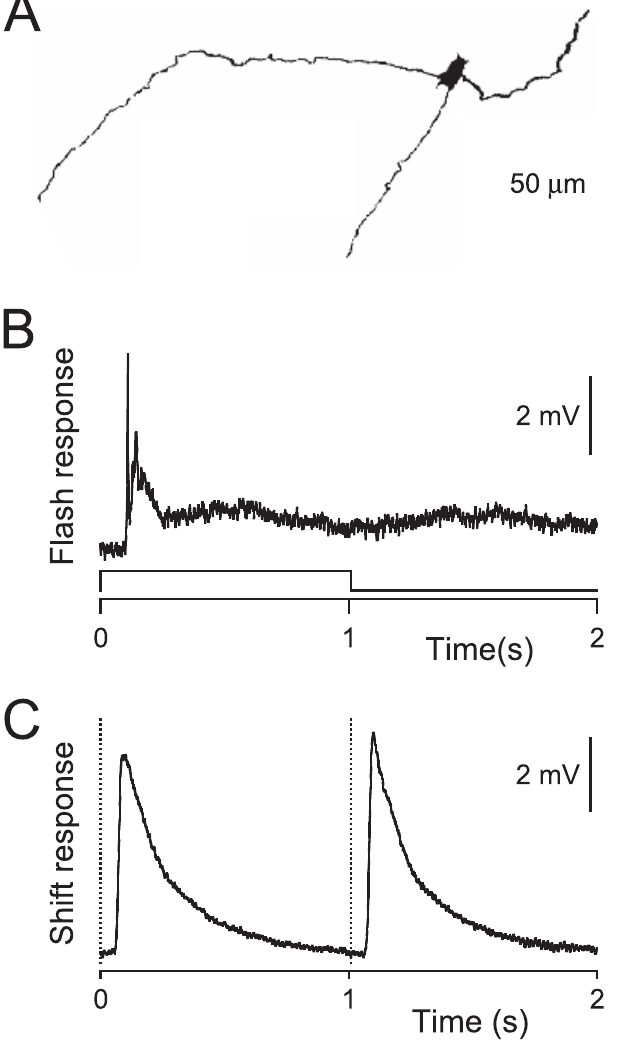
Figure 8. A Peripheral Shift Depolarizes On-Transient Amacrine Cells (A) Intracellular fill of an On-transient amacrine cell in whole-mount view. (B) Intracellular recording of the response to a full-field light flash (bottom trace). Occasionally, action potentials (truncated in this graph) were observed at light onset. Resting potential (cid:2) 77 mV. Single trial. (C) Response to a large grating (see Figure 1A), shifting by a half period every 1 s (vertical lines). Average over 15 trials. Note the depolarizing response is identical to grating shifts of both signs.